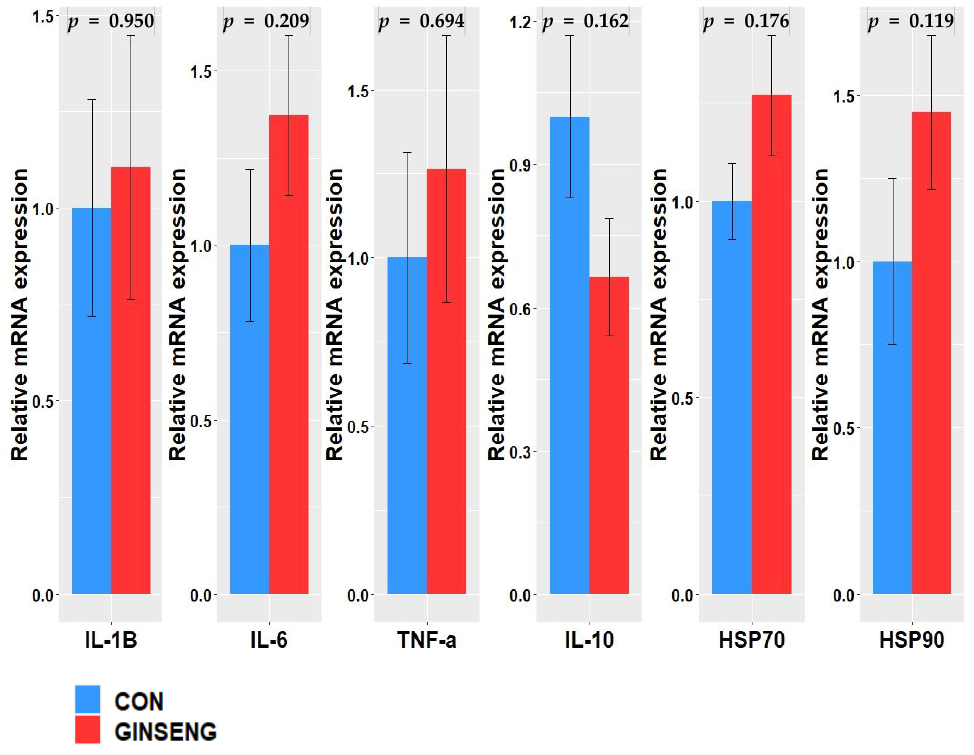
Figure 1. Differences in gene expression of inflammatory cytokine and heat shock protein in Han-